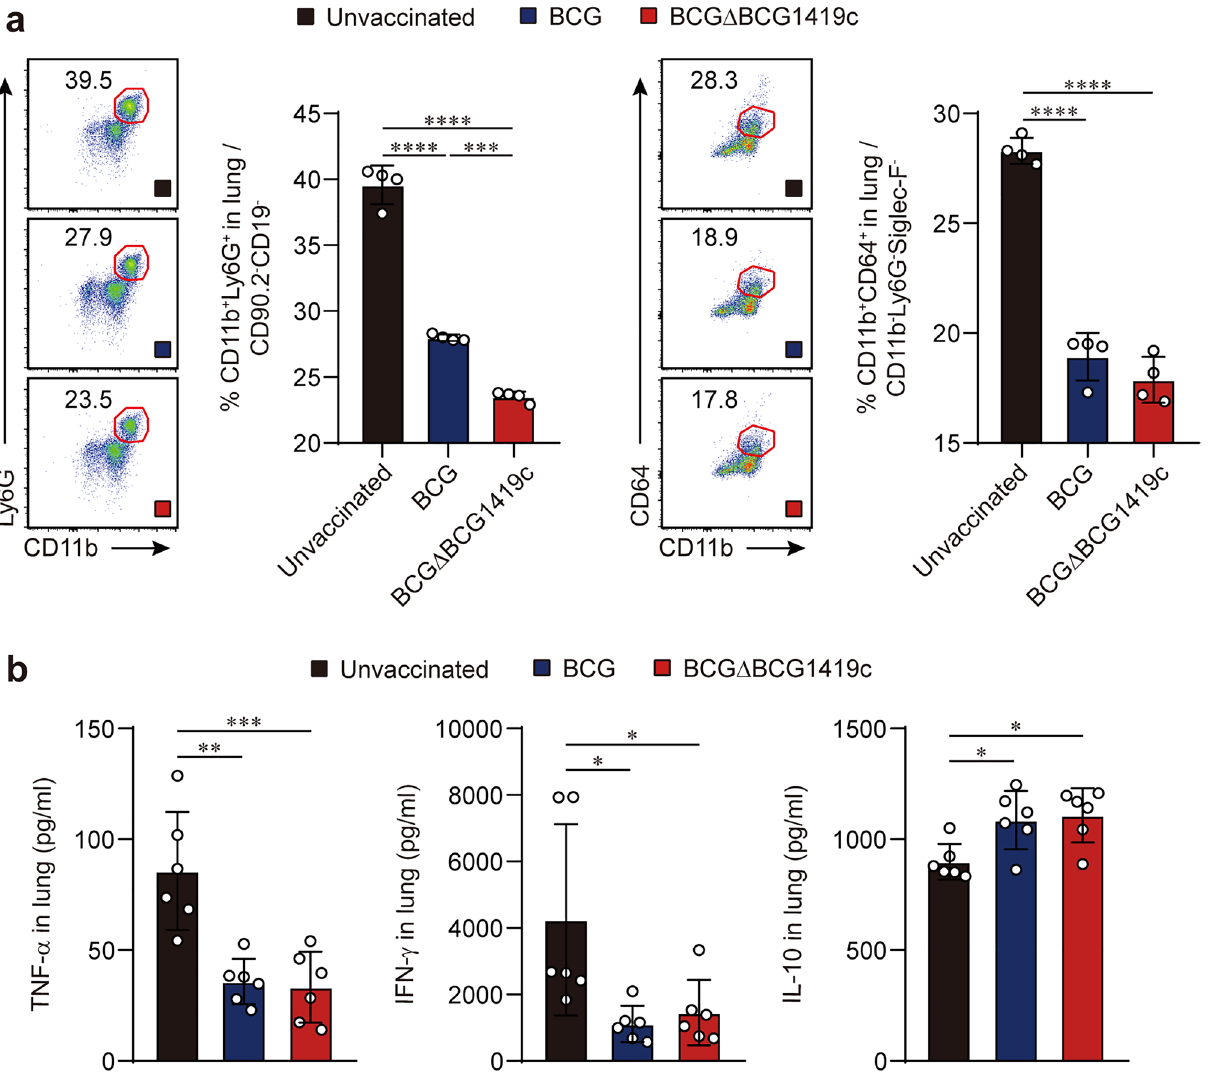
Figure 5. Assessment of local immune responses represented by cytokine production and cellular infiltration in BCG- and BCGΔBCG1419c-vaccinated mice after infection. ( a ) The frequencies of neutrophils and macrophages in the lungs of each group were evaluated at 10 weeks post-infection. The experimental results of one representative experiment are presented as the mean ± SD from pooled samples ( n = 4) from each group ( n = 6). One-way ANOVA with post hoc Tukey’s multiple comparison test was used to evaluate the significance. *** p < 0.001, and **** p < 0.0001. ( b ) At 10 weeks post-infection, lung lysates from each group ( n = 6) were used to quantify the levels of TNF-α, IFN-γ, and IL-10. Data are expressed as the mean ± SD from each group ( n = 6). One-way ANOVA with post hoc Tukey’s multiple comparison test was used to evaluate the